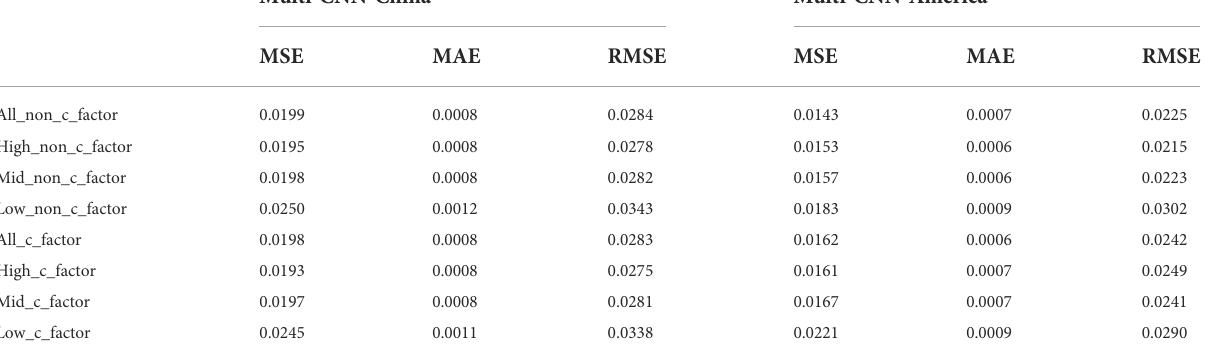
TABLE 3 Evaluation of prediction accuracy using Multi-CNN method with and without carbon factor in feature engineering Note: This table records the values of MSE, RMSE and MAE used to evaluate the prediction accuracy of Multi-CNN method. And all, high, mid as well as low represent the full stock, high-carbon, medium-carbon as well as low-carbon sectors respectively. Meanwhile, the values of Chinese market and American market arerecordedrespectively.Overall,inthecaseoffeatureengineeringwithandwithoutcarbonfactor,thevaluesofeachforecastaccuracyassessment indicator in different industries are small, indicating that the methodology has good forecasting effect and high forecast accuracy.